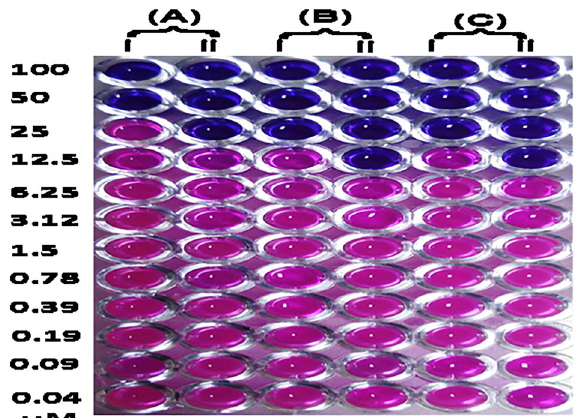
Figure 2. Determination of minimum inhibitory concentration of PtNPs. ( A ) A. hydrophila , ( B ) E. fecalis , ( C ) S. iniae . While (i) is having PtNPs alone and (ii) is having 25 µM Md-Lec and